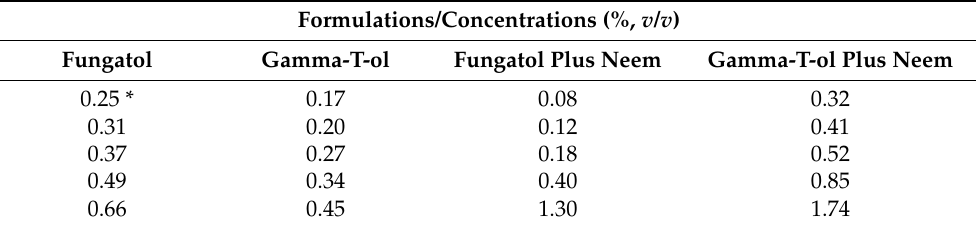
Table 2. Concentrations of each tested formulation used in mummy spraying